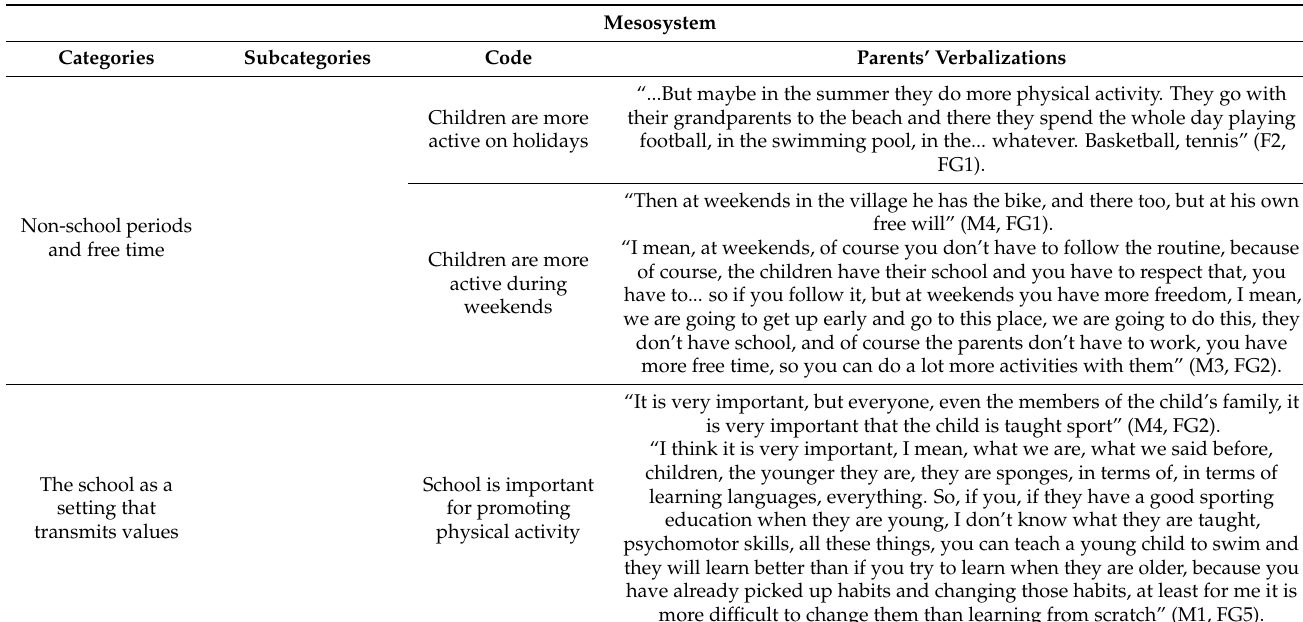
Table 10. Mesosystem facilitators for physical activity among schoolchildren.